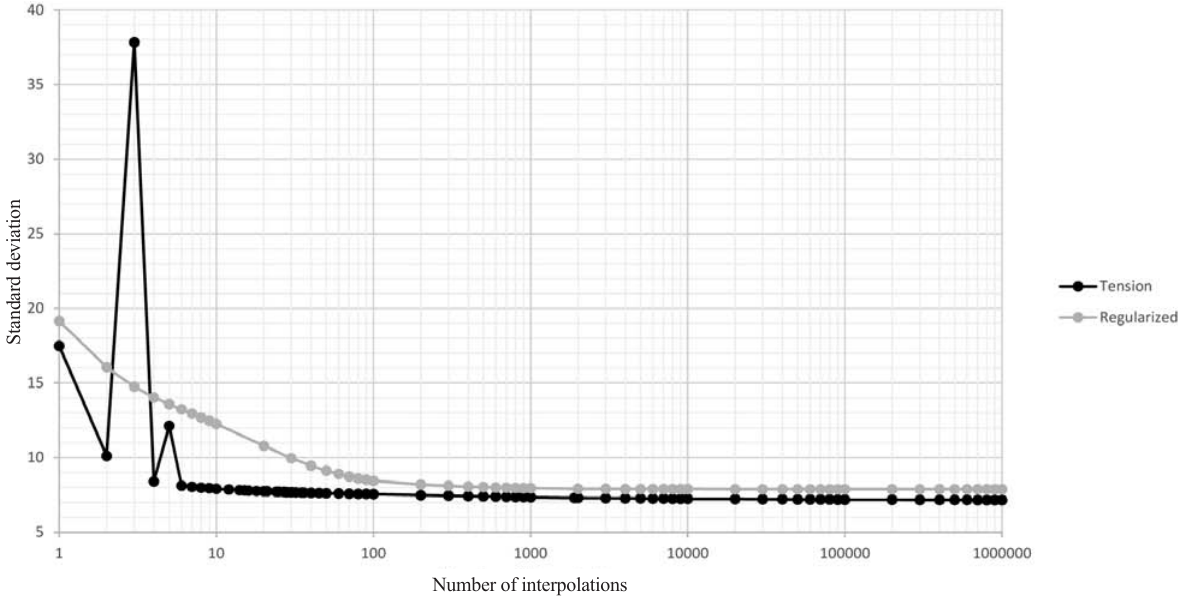
Fig. 4. The chart of standard deviation values of all the interpolated surfaces by the Spline method.